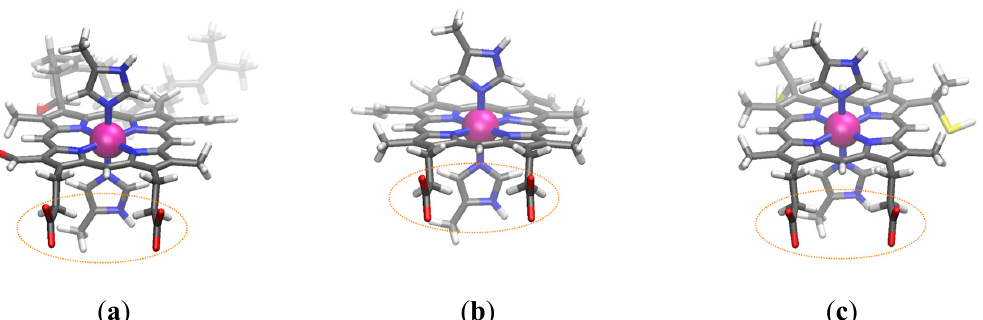
Figure 3. The optimized geometries of heme compounds: ( a ) heme a , ( b ) heme b , and ( c ) heme c